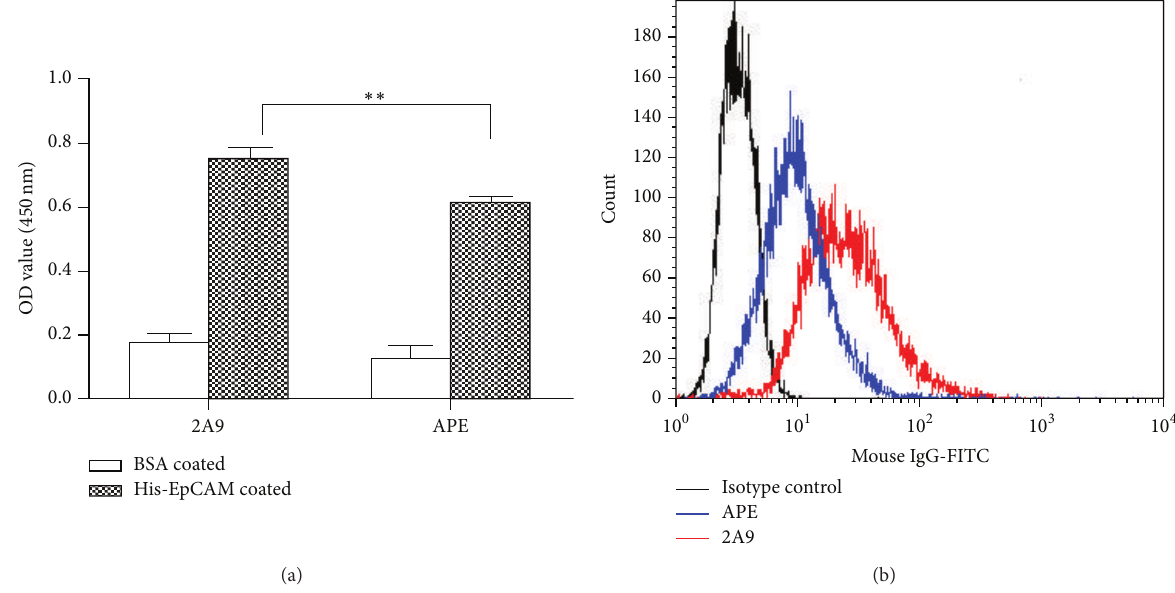
Figure 5: Binding ability of immunotoxin to recombinant His-EpCAM and natural EpCAM. (a) Recombinant HIS-EpCAM protein was coated on 96-well plates (5 𝜇 g/mL). The binding of the immunotoxin to His-EpCAM was detected by ELISA. The 𝑃 value was analyzed by an unpaired Student’s 𝑡 -test. ∗∗ 𝑃 value was less than 0.05. (b) HHCC cells were collected and stained with primary antibody (biotin labeled immunotoxin, biotin labeled 2A9, or biotin labeled isotype control antibody) at a concentration of 5 𝜇 g/mL and FITC labeled avidin (1: 50) as the secondary antibody. Fluorescence was detected by BD FACS Calibur. The mean fluorescent intensity was measured by FlowJo